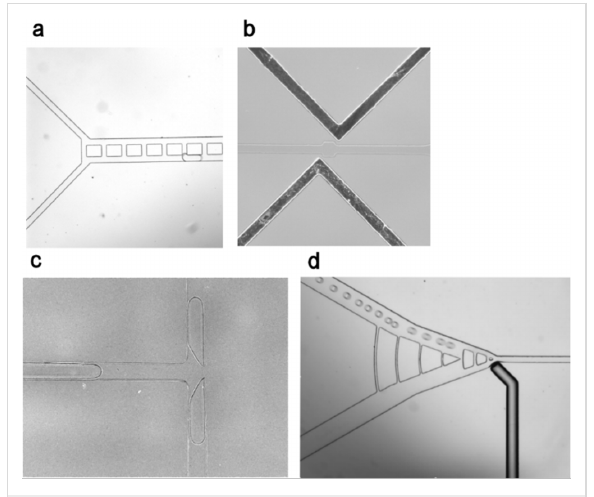
Figure 8: Photographic images of individual microfluidic modules, fabricated our laboratory in PDMS from standard soft lithography masters: a) droplet synchroniser for b) droplet fuser; c) droplet splitter; d) droplet sorter with air pressure-activated mechanical